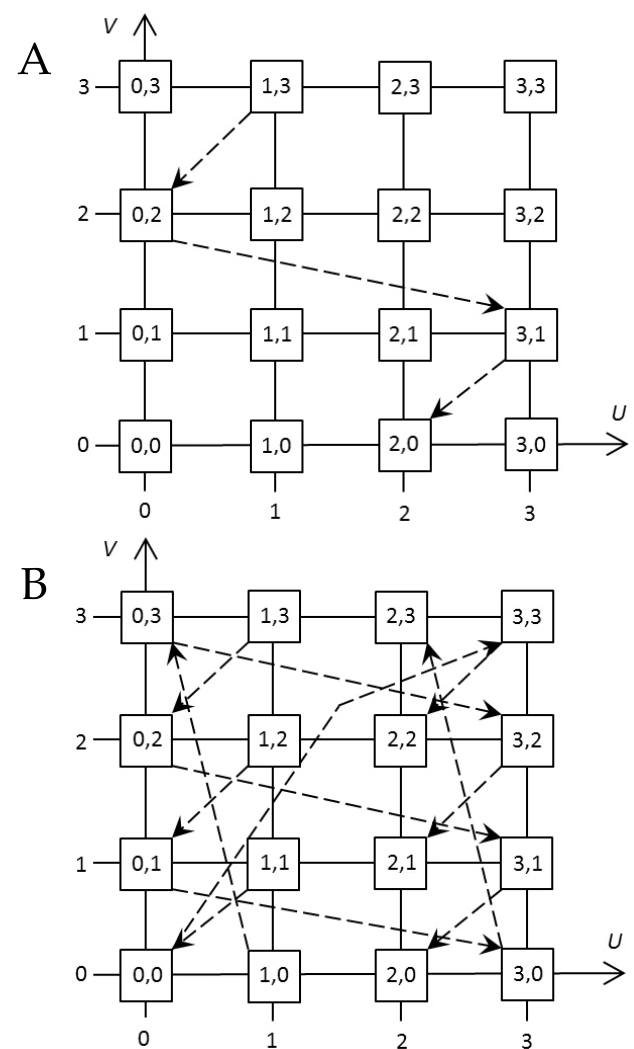
Figure 7. ( A ) A random track and ( B ) a possible set of tracks for one complete stochastic matrix. using nsDeonYuliPlaneTwist32D; //plane twist generator